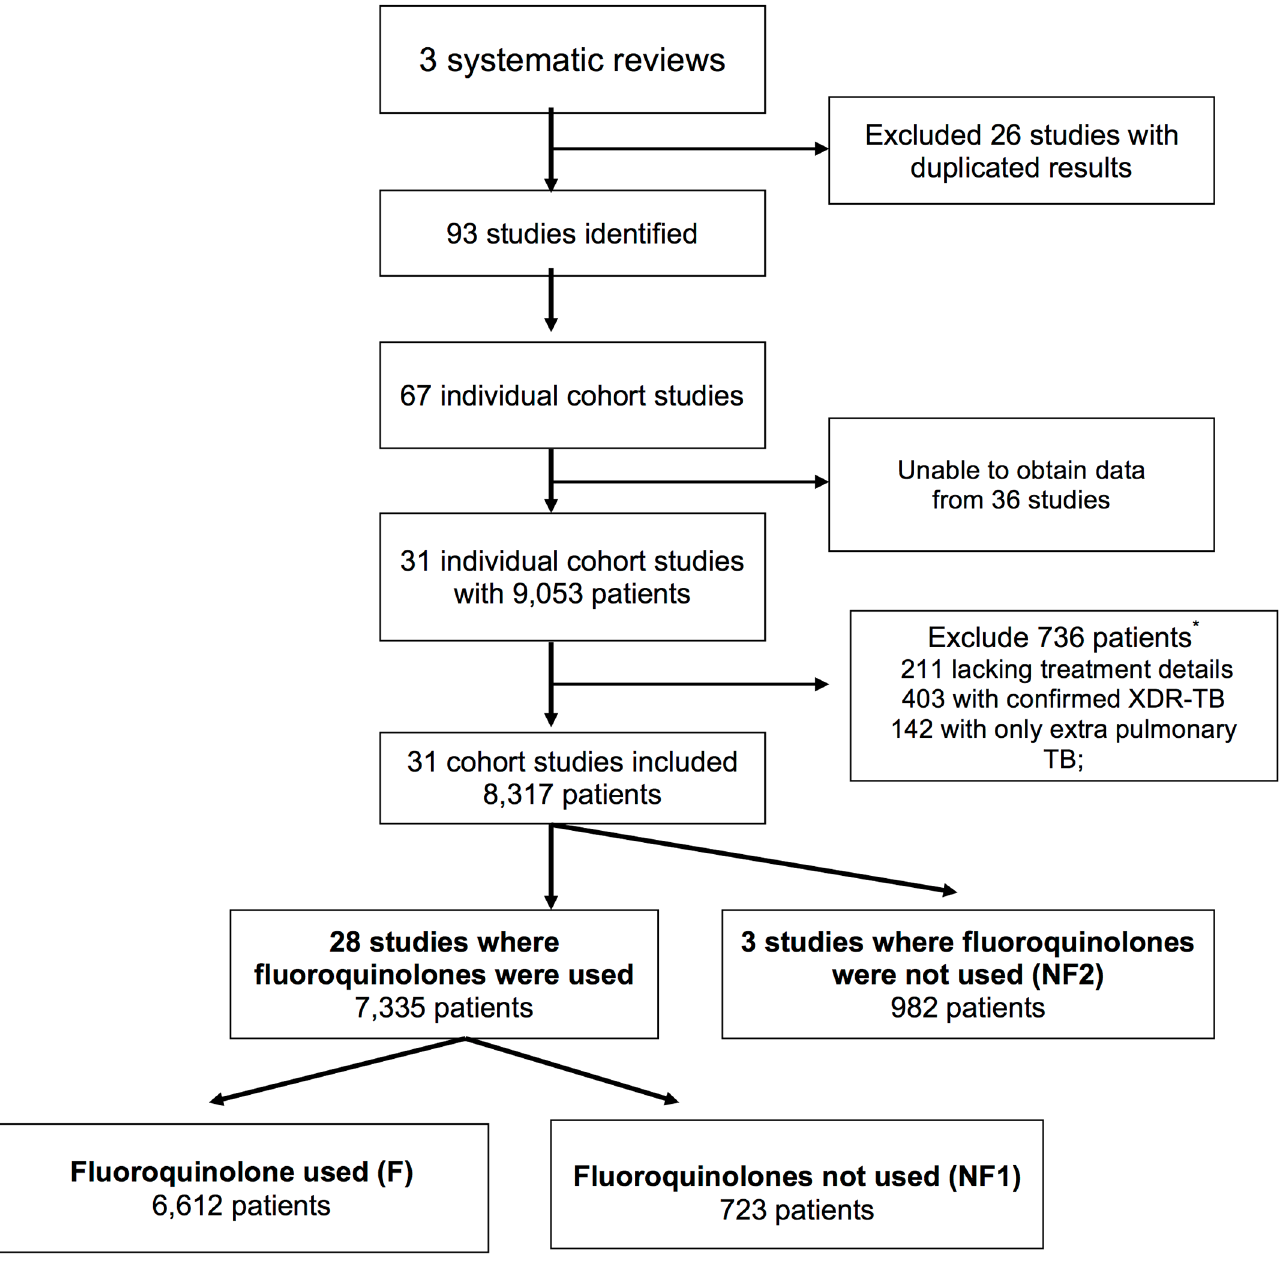
Fig 1. Consort diagram showing patient selection for an individual patient data meta-analysis of the effectiveness of fluoroquinolone antibiotics to treat multi-drug resistant tuberculosis. Group allocation was independent of which other antibiotics were concurrently used. * Some patients were excluded on the basis of more than one